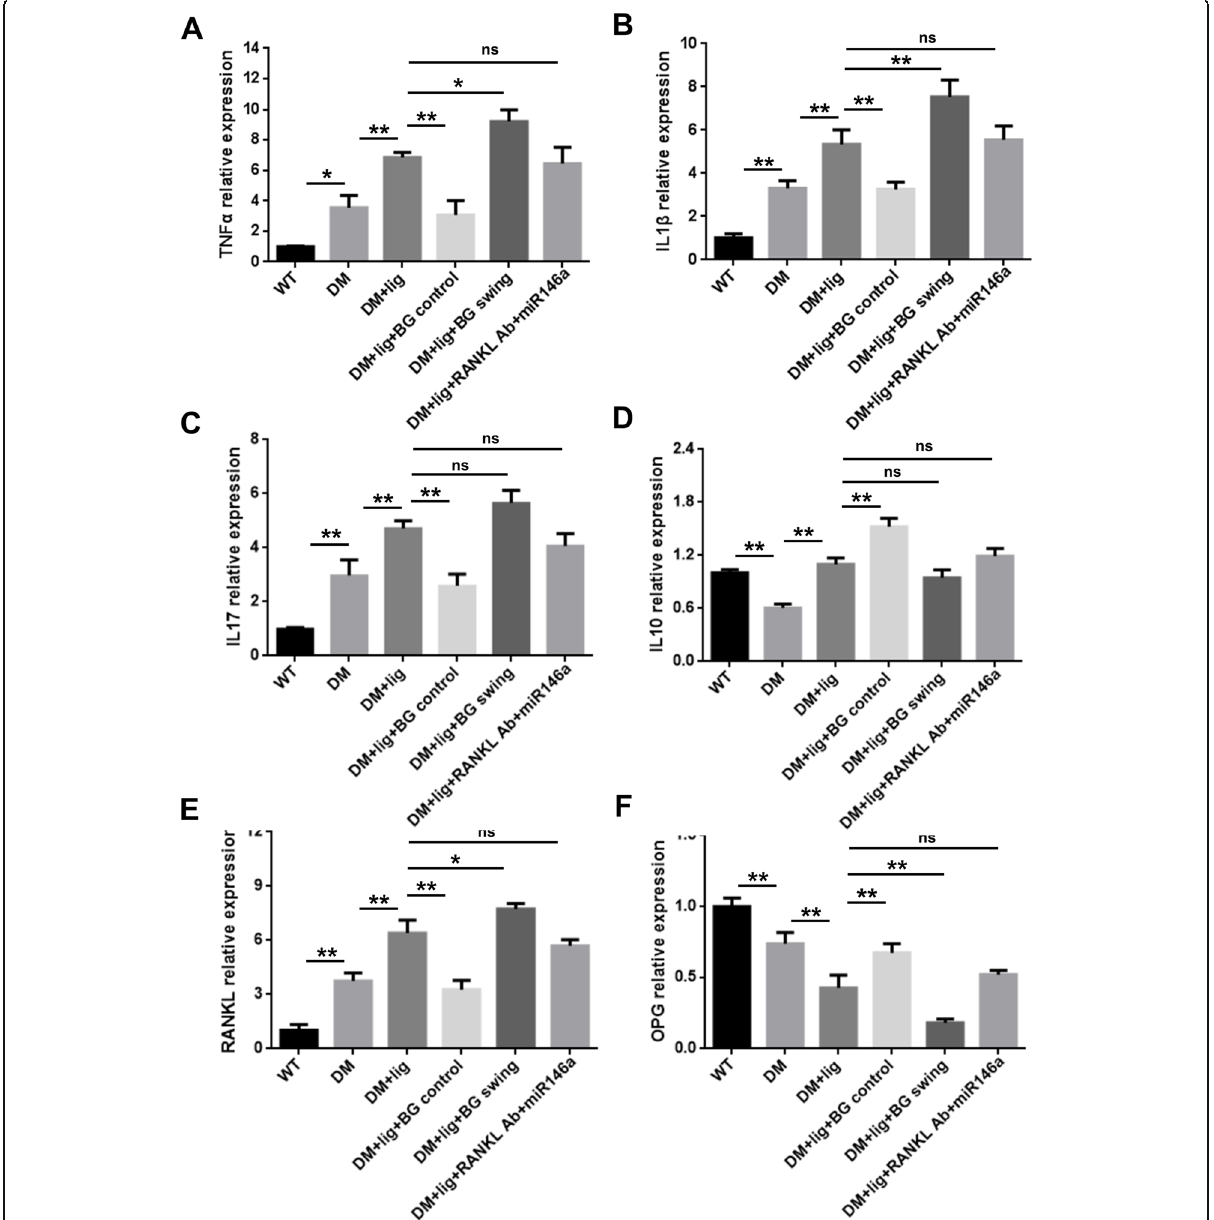
Fig. 4 The mRNA expression of inflammatory cytokines and bone formation proteins in peri-implant gingival tissues. Gingival tissues around ligatured site were excised and processed for RT-qPCR analyses to determine mRNA level of a TNF- α , b IL-1 β , c IL-17, d IL-10, e RANKL, and f OPG (mean ± SD, n = 3, * p < 0.05, ** p < 0.01, ns, no